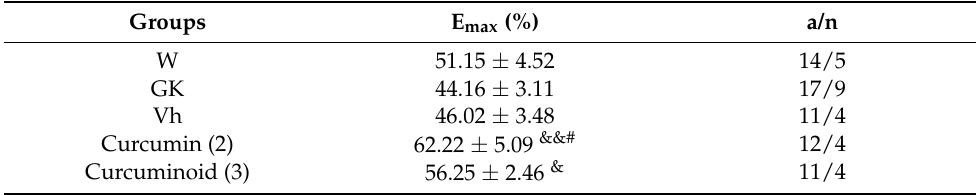
Table 1. Maximum contractile response (E max ) 1 to acetylcholine of aorta isolated from the different experimental